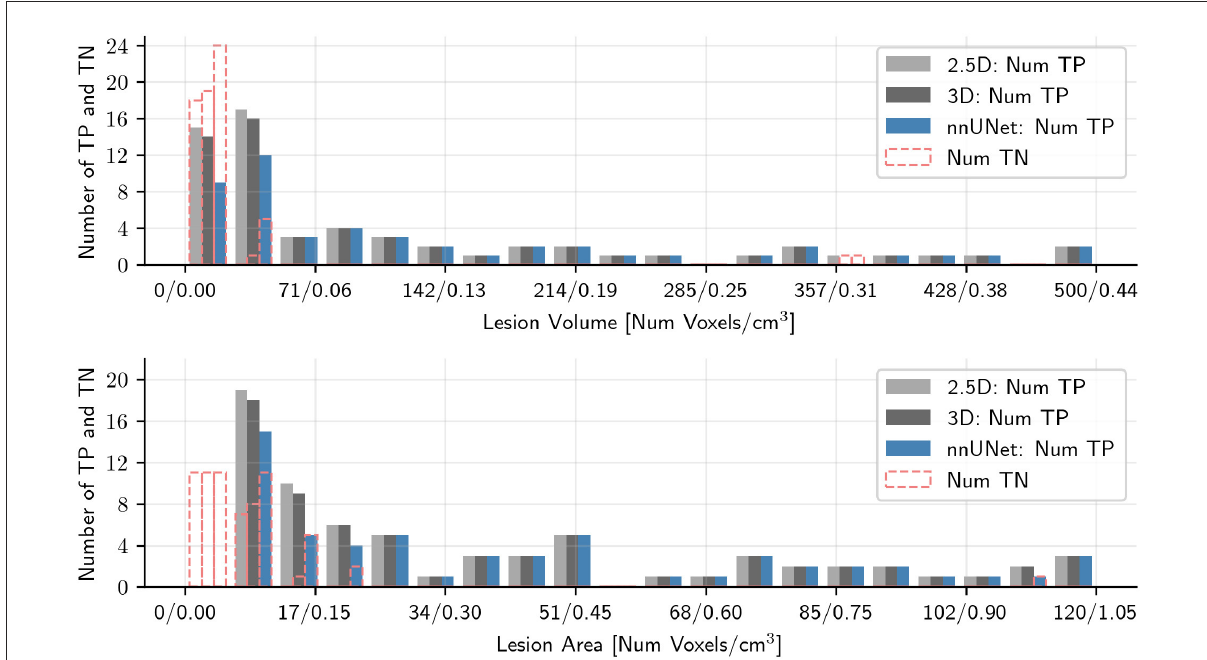
FIGURE4 Histogram plots of the number of correctly predicted metastases and the number of missed metastases as a function of the maximum metastatic area in the axial plane and metastatic volume for the OUH cohort for all three models tested. Metastases larger than 120 (area) or 500 (volume) voxels were excluded to improve readability. TP denote true positive metastases, i.e., correctly predicted metastases, and TN denotes true negative metastases, i.e., not predicted metastases.